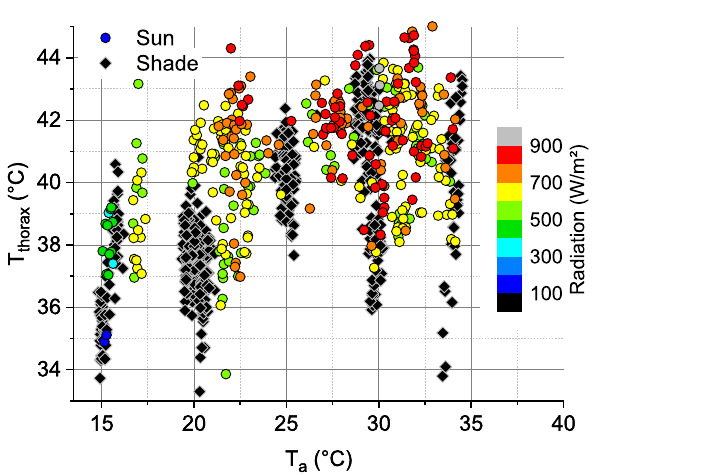
Figure 2. Mean thorax surface temperature per stay at an artificial flower (T thorax ) in relation to ambient air temperature (T a ) and global radiation. Shade ≤ 100 W m -2 , sunshine > 100 W m −2 . Bees fed 1.5 M sucrose solution in unlimited flow (data from 17 ), or 0.5 M sucrose in unlimited flow and limited flow of 15 µl min −1 (data from 18 ). For simultaneously measured energy turnover see Fig. 3a and supplementary Fig.